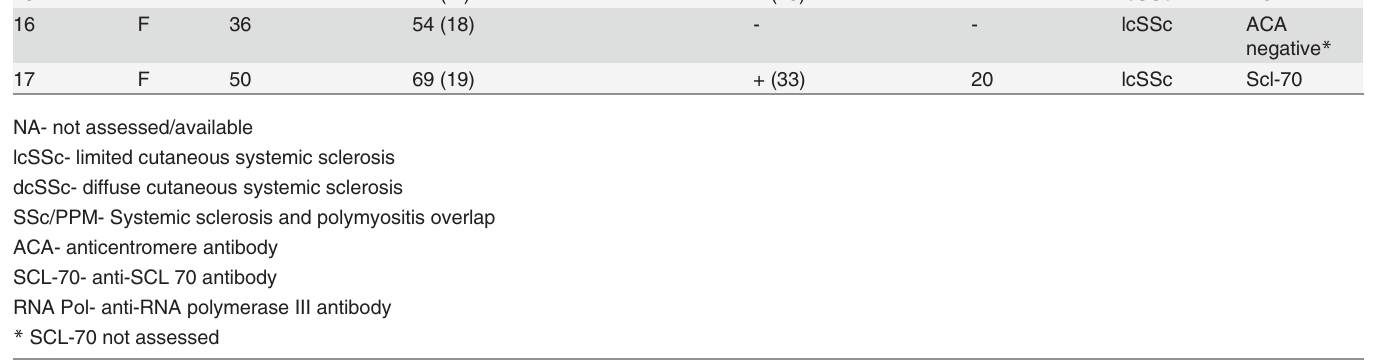
for a head and neck cancer. Prior to cancer diagnosis, two patients had been treated with cyclo- phosphamide, one with a tumor necrosis factor inhibitor, one with azathioprine, and three with mycophenolate mofetil. Systemic Sclerosis Systemic sclerosis was classified as limited cutaneous (lc) in 13 cases (76%), diffuse cutaneous (dc) in 3 (18%) and SSc/polymyositis overlap in 1 (Table 1). This distribution of disease is simi- lar to that in our SSc registry (63%, 36% and 1% for lc, dc and SSc/myositis overlap respective- ly) (p = 0.14). Results of serologic testing were available for 15 of 17 cases: 13/15 (87%) antinuclear antibody positive, 7/14 (50%) scl-70 antibody (Scl-70) positive, and 4/15 (27%) anticentromere antibody (ACA) positive. RNA Polymerase III antibody titer (RNA pol) was measured in 10 cases and was positive in 2 (20%). The distribution of positive serologic mark- ers in our registry was 24%, 25% and 22% for ACA, Scl-70 and RNA pol respectively, similar to that reported in the literature.[22] The Scl-70 positive cases were significantly more in cases compared with our registry patients (p = 0.04).